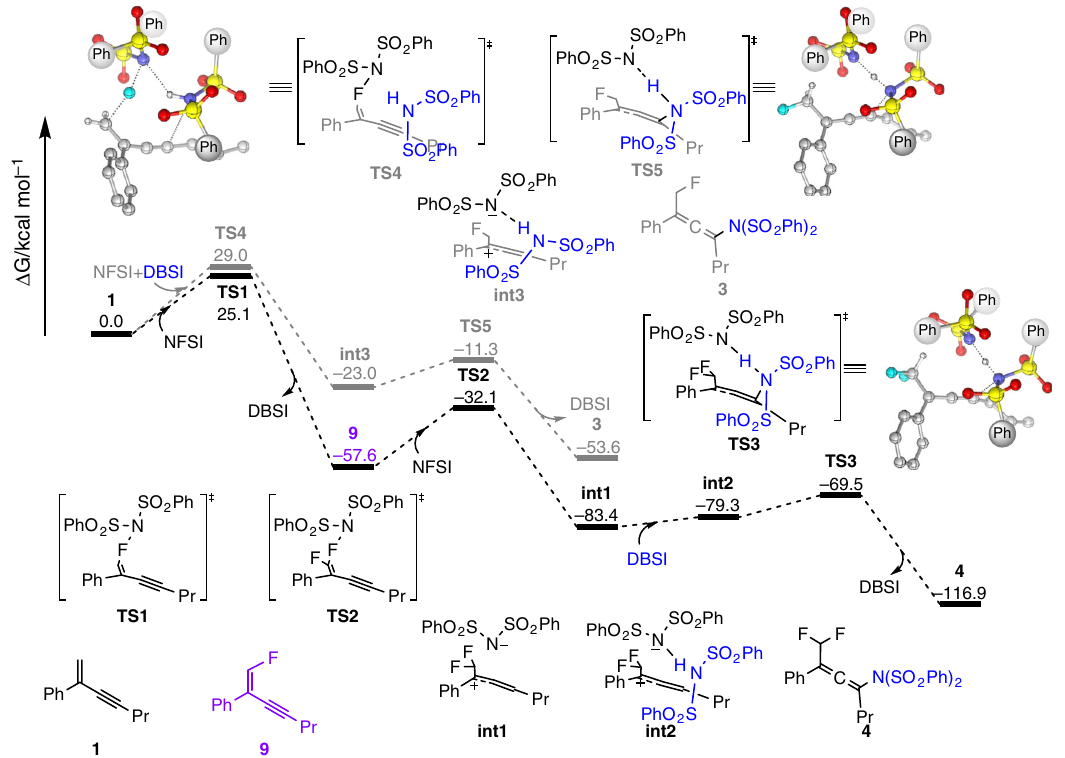
Fig. 5 DFT study. The free energy pro fi le of formations of fl uoroamination and di fl uoroamination products, 3 and 4 .